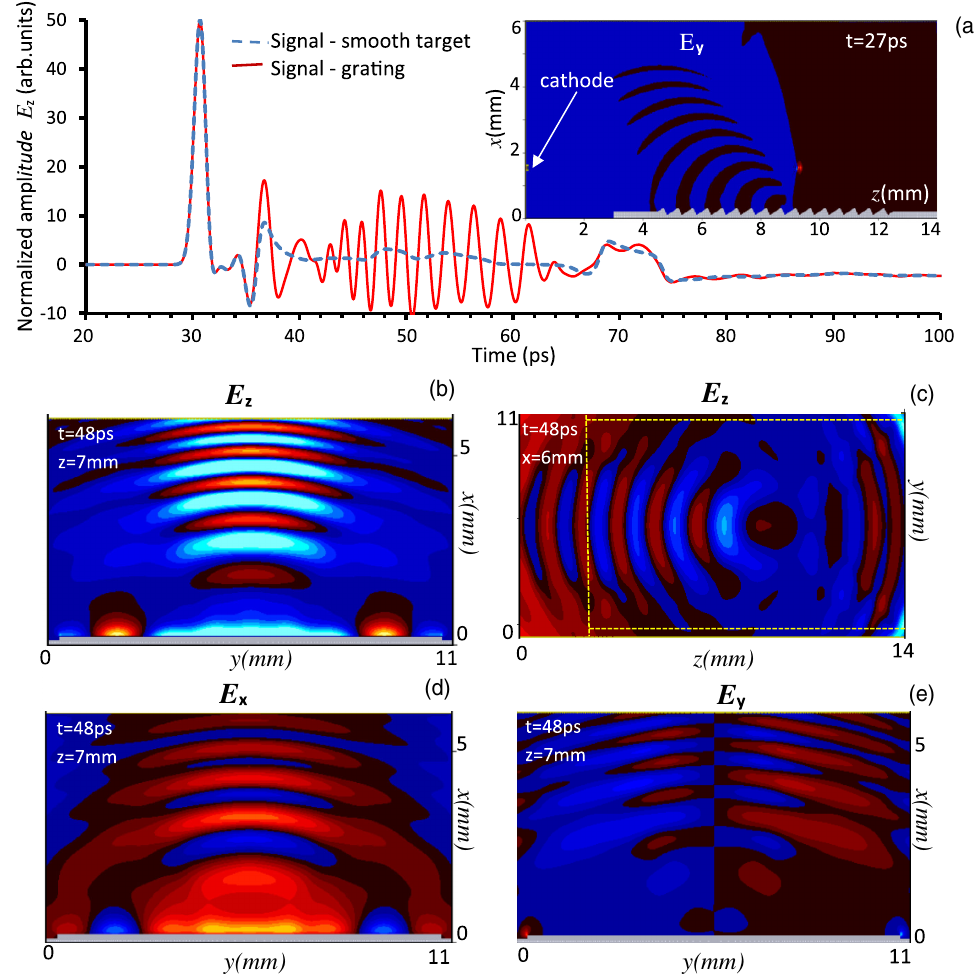
FIG. 2. The results of the numerical studies of the cSPr using 3D PIC code MAGIC showing: (a) the amplitude of the waveforms of the signals ( E field component) generated by one-dimensional grating of 0.6 mm period (solid line) and smooth metal plate (dashed line) of z the same geometry (blank target). The inset shows the grating and the contour plot of E field component at t ¼ 27 ps; (b) – (d) the y contour plots of the electric field components ( E ) showing the radiating field of cSPr generated by the 0.6 mm grating at t ¼ 50 ps. z;x;y The contour plots (b), (d) and (e) are observed for the ( x , y ) cross section at z ¼ 7 mm (middle of the grating). The formation of the side lobes (field variation along y coordinate) is shown in parts (b) and (d). Part (c) shows the contour plot in the ( y , z ) plane, i.e., view from the top. The dashed line on (c) shows the borders of the